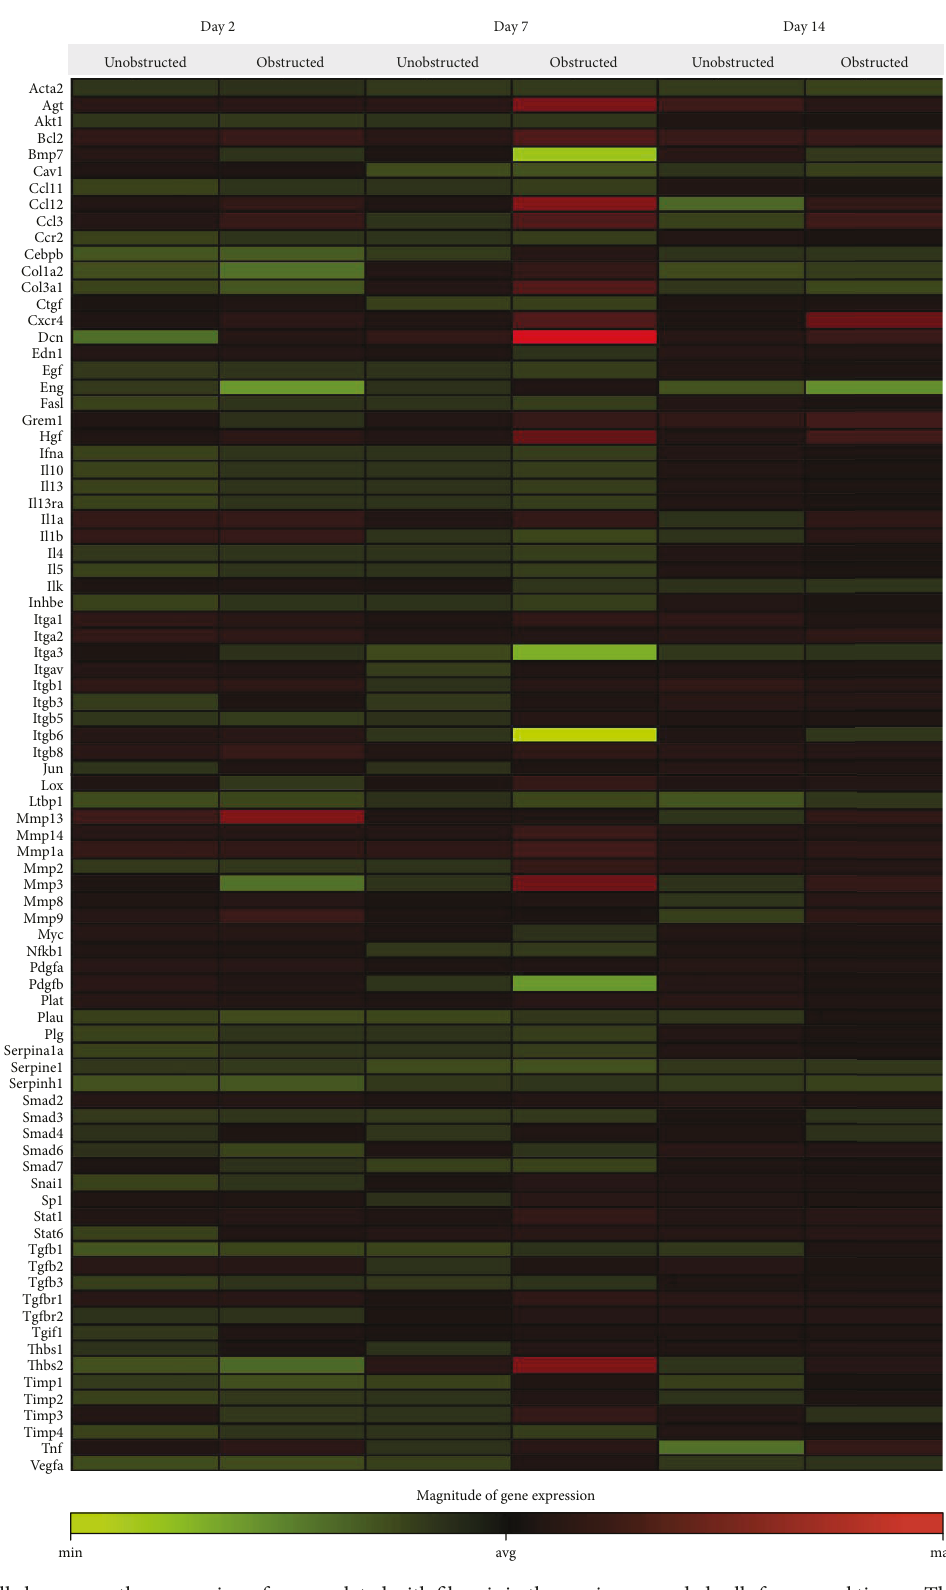
Figure 5: Overall changes on the expression of genes related with fi brosis in the ex vivo expanded cells from renal tissues. The heat map shows the overall changes of expression of genes including in the mouse fi brosis RT 2 pro fi ler PCR array. Twice-passaged cells are used for analysis, and the expression levels are comparing to the sham